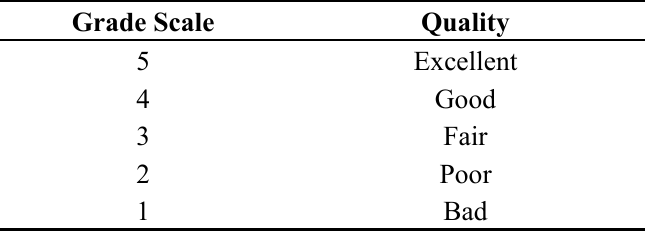
Table 1. Comparison scale for the subjective quality evaluation